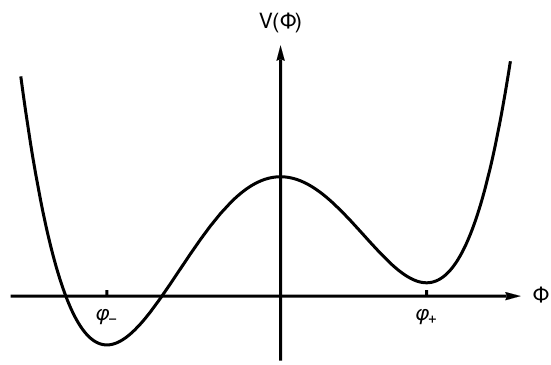
Figure 1. The classical potential V ((cid:8)) for a theory with a false